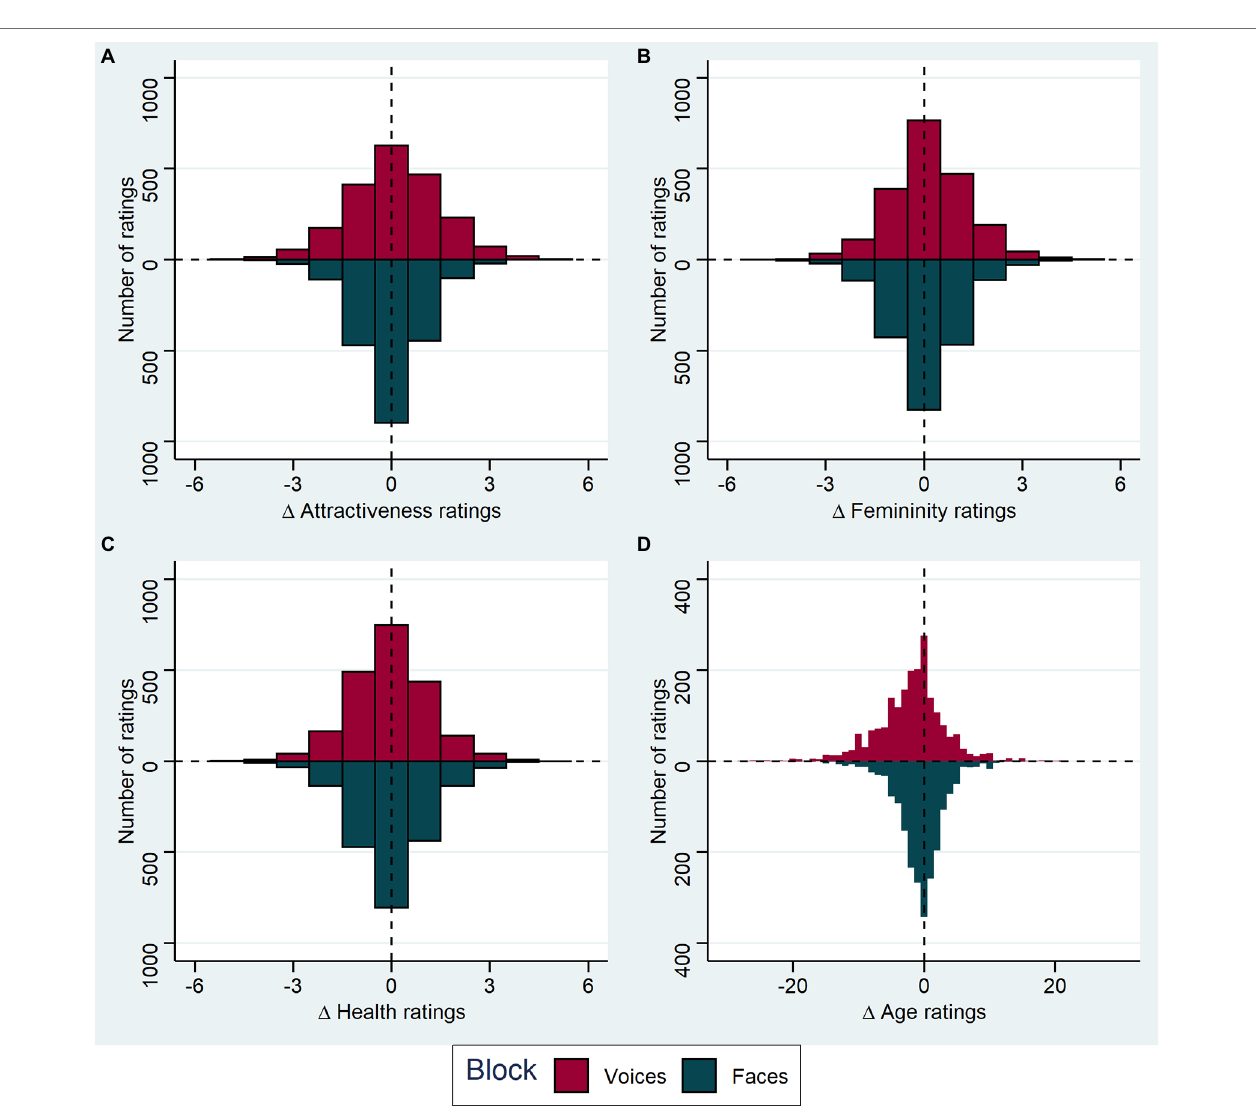
FIGURE 3 | Effect of pitch manipulation on ratings. (A) The distribution of attractiveness rating differences for increased pitch minus original pitch is shown as a histogram, with results from the audio block (voice ratings) shown above the horizontal line (dark pink bars) and results from the audiovisual block (face ratings) shown below (dark cyan bars). Each stimulus and subject combination is included (for voices n = 2078, for faces n = 2075); ratings were given on a 7-point Likert scale. (B) as in (A) , for femininity ratings (for voices n = 2016, for faces n = 2012). (C) Health ratings (for voices n = 2076, for faces n = 2076). (D) Age ratings (for voices n = 2059, for faces n = 2068). Age was rated in